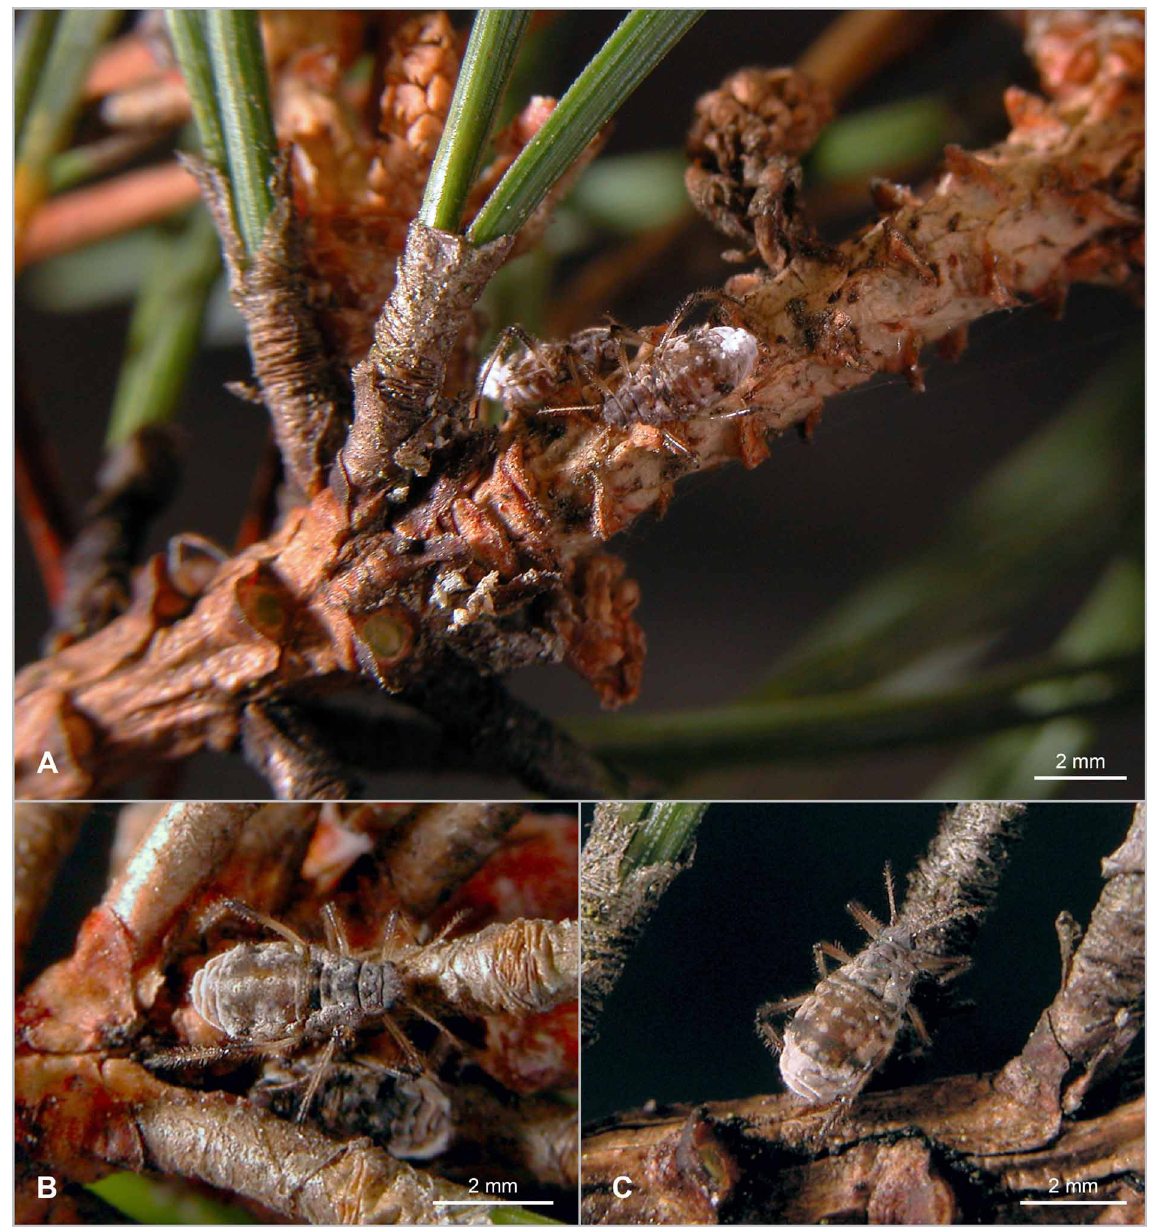
Fig. 94. Cinara (Cinara) pinihabitans (Mordvilko, 1895). Oviparae on Pinus sylvestris